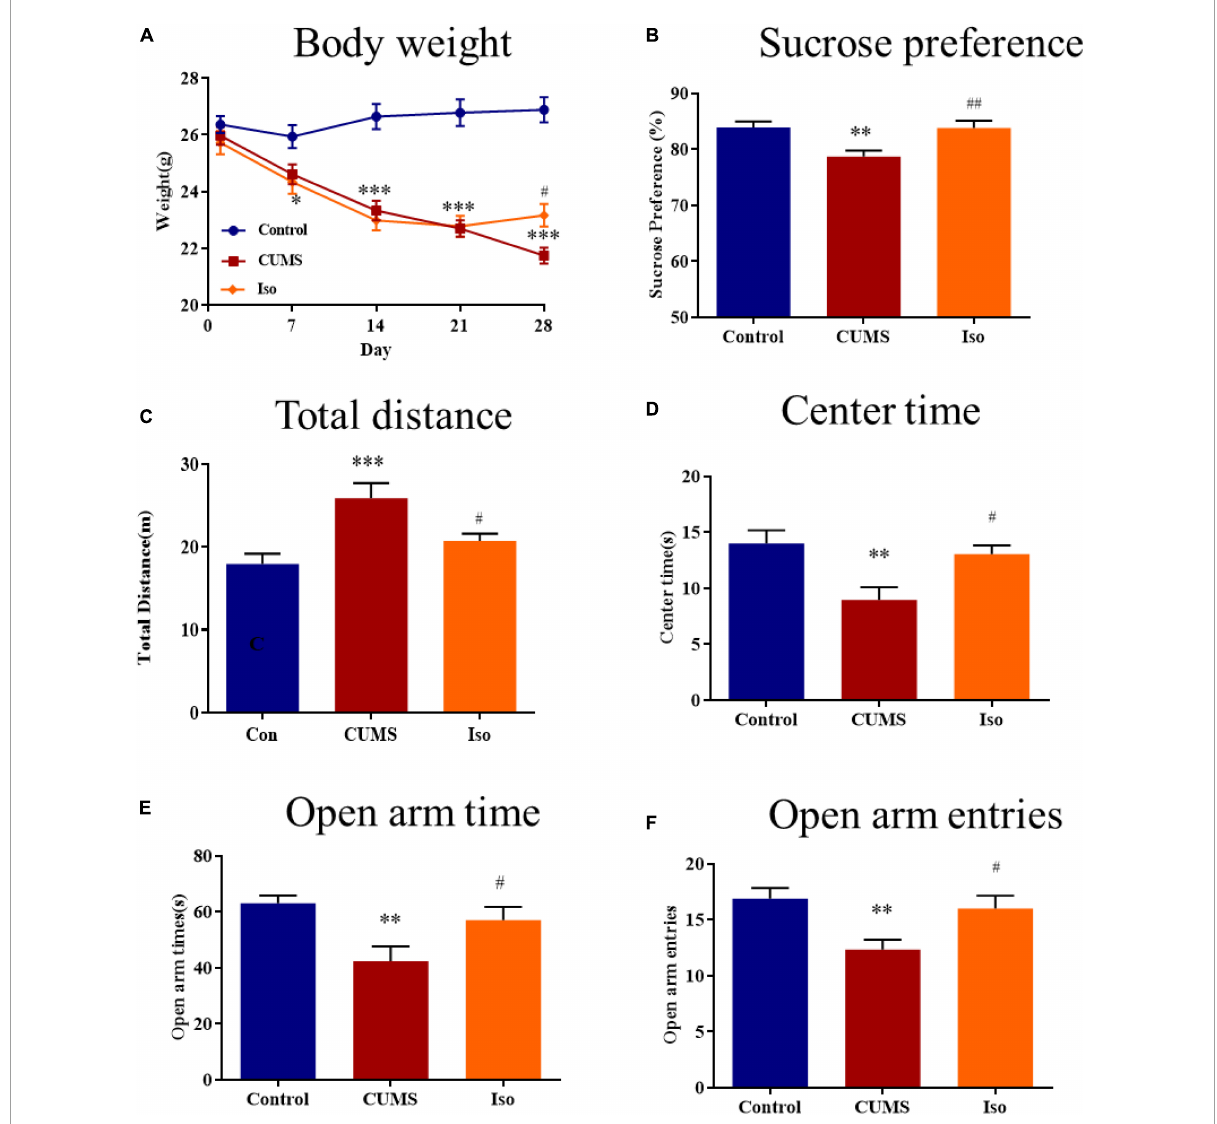
FIGURE2 Effects of isorhynchophylline on body weight, sucrose preference, open field test and elevated plus maze in CUMS mice. (A) Isorhynchophylline significantly alleviated CUMS-induced body weight loss. (B) Isorhynchophylline significantly increased sucrose preference index in CUMS mice. (C) Isorhynchophylline significantly decreased total distance in CUMS mice. (D) Isorhynchophylline significantly increased central retention time in CUMS mice. (E) Isorhynchophylline significantly increased open arm times in CUMS mice. (F) Isorhynchophylline significantly open arm entries in CUMS mice. The data are presented as mean ± SEM. ∗∗ P < 0.01, ∗∗∗ P < 0.001 compared to the Con group; # P < 0.05, ## P < 0.01 compared to the CUMS group.